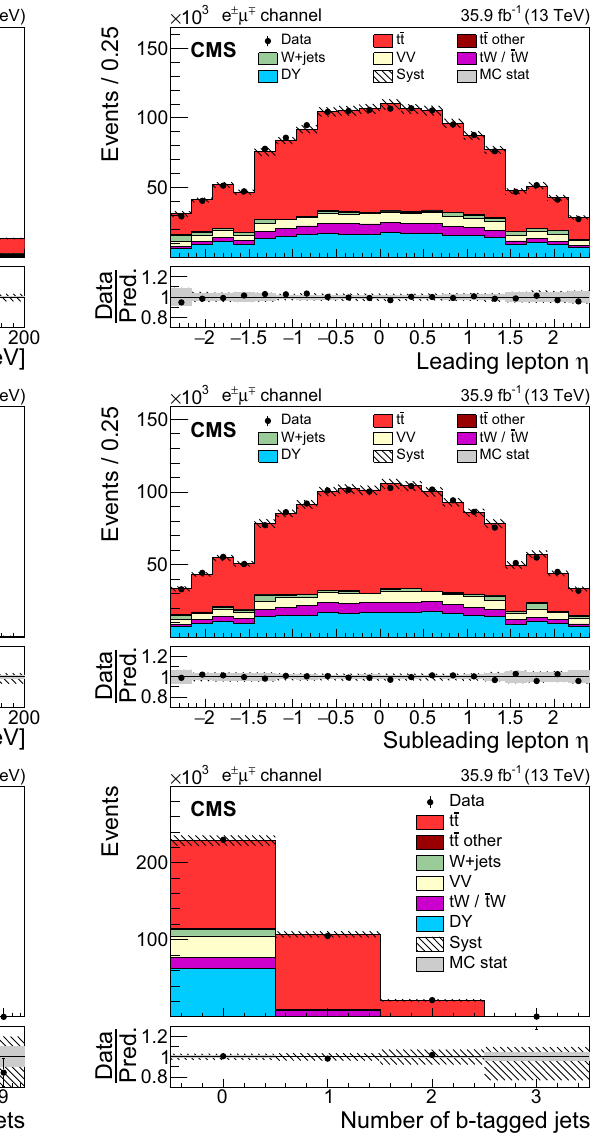
bands correspond to the systematic uncertainty in the tt signal MC sim- ulation. The uncertainties in the integrated luminosity and background contributions are not included. The ratios of the data to the sum of the predicted yields are shown in the lower panel of each figure. Here, the solid gray band represents the contribution of the statistical uncertainty in the MC simulation